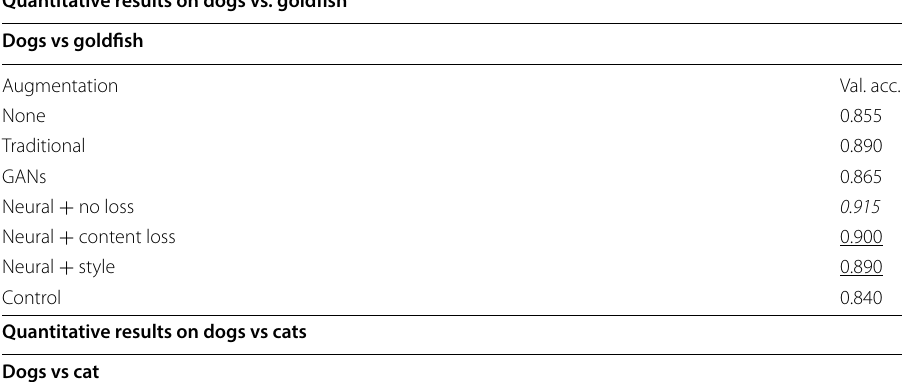
Table 7 Results comparing augmentations [36] Quantitative results on dogs vs. goldfish Dogs vs goldfish Augmentation Val.